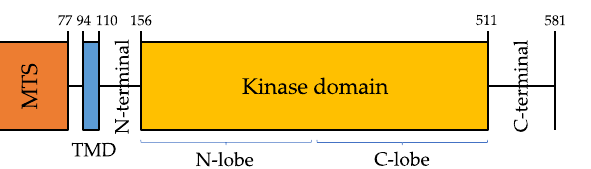
Figure 1. Domain architecture of PINK1 (581 amino acids). Mitochondrial targeting sequence (MTS, orange), transmembrane domain (TMD, blue).